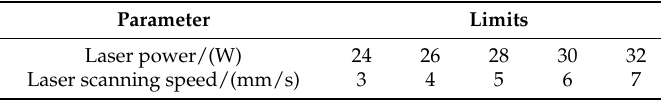
Figure 1. The schematic of laser transmission welding between PE (polyethylene) and POM Figure 1. TheschematicoflasertransmissionweldingbetweenPE(polyethylene)andPOM(polyoxymethylene). (polyoxymethylene). Table 2. Process parameters and limits. Table 2. Process parameters and limits.